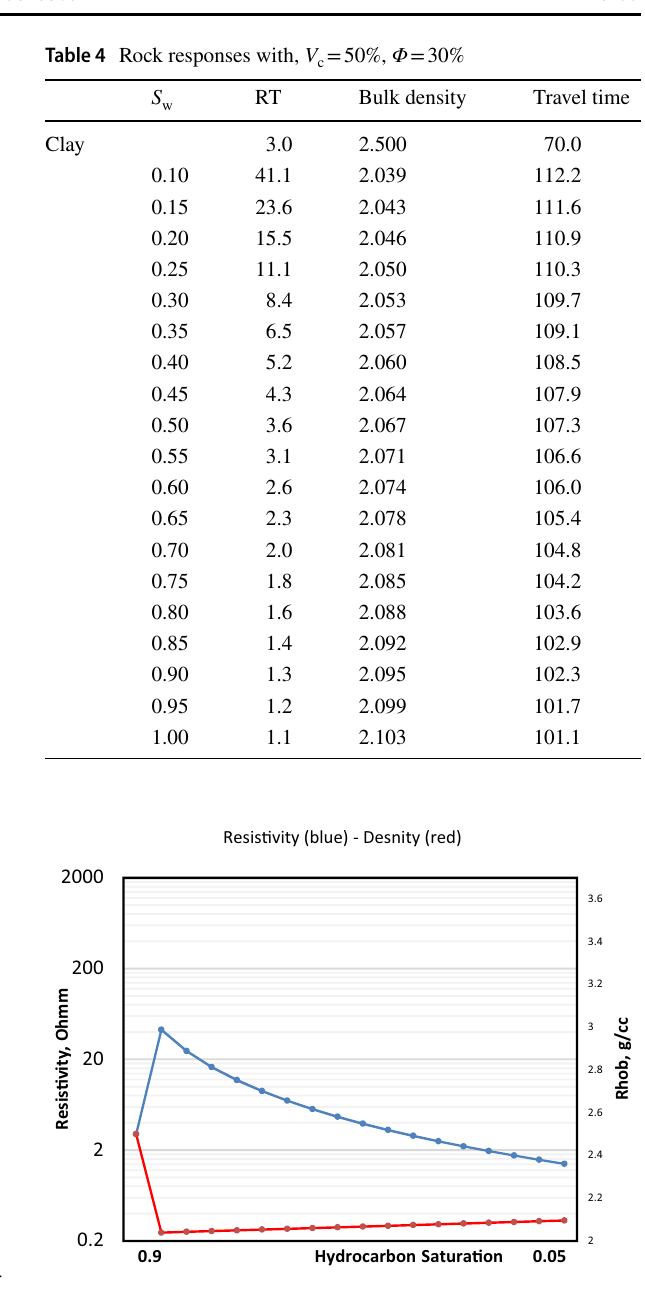
Fig. 8 Density–resistivity overlay, V